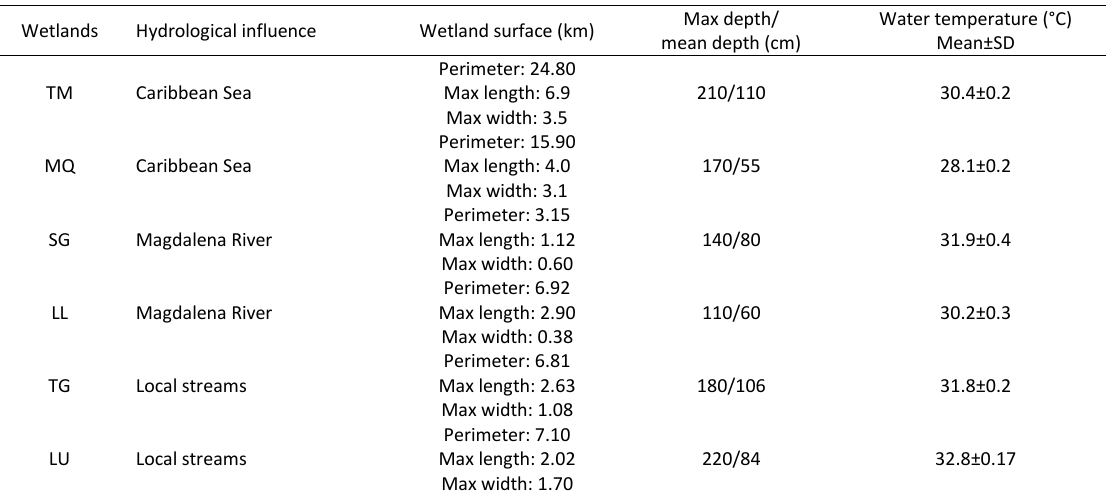
Fig. 1: Geographic location of the studied wetlands and sampling points (A. TM wetland; B. MQ wetland; C. SG wetland; D. LL wetland; E. TG wetland; F. LU wetland) Table 2: Characteristics of wetlands sampled